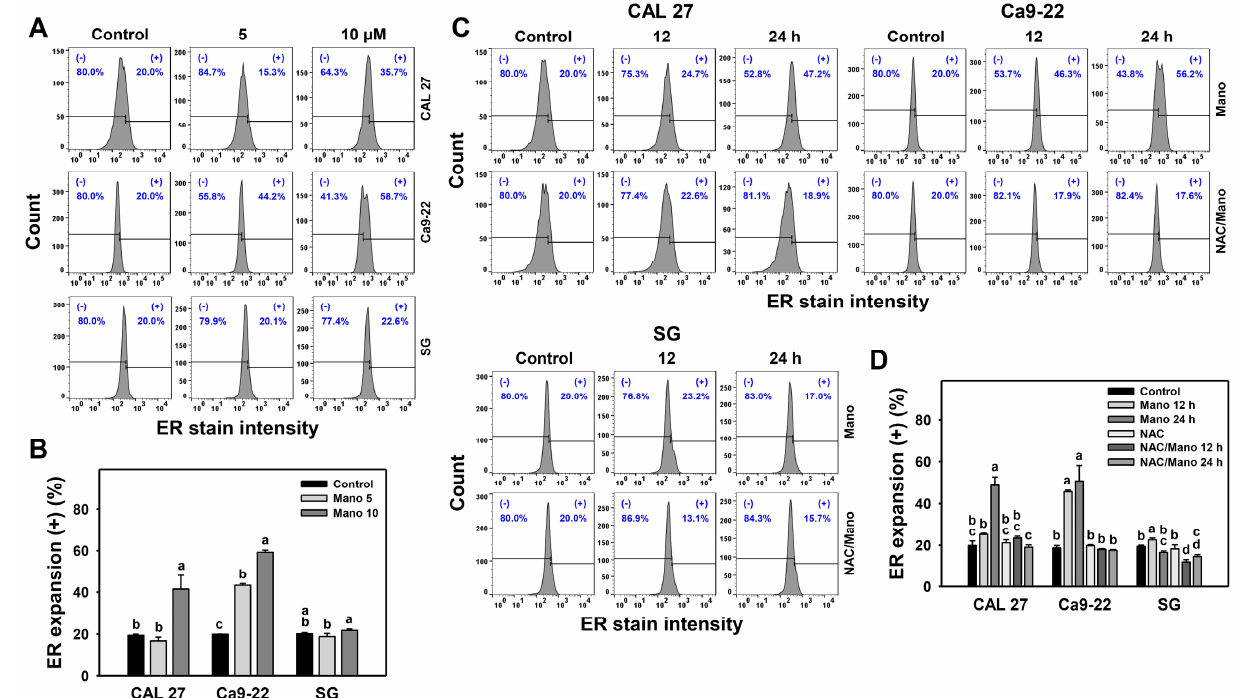
Figure 1. Manoalide causes ER expansion of oral cancer cells. ( A , B ) ER expansion analyses. Oral cancer (CAL 27 and Ca9-22) and normal oral (SG) cells received control, 5, and 10 µ M manoalide treatments for 24 h. (+) was marked for ER expansion (+) (%). ( C , D ) NAC effects on time course changes of manoalide-induced ER expansion. Following NAC (10 mM for 1 h), cells received manoalide treatment (control and 10 µ M) for 12 and 24 h, i.e., NAC/Mano. Data, means ± SDs ( n = 3). Multiple comparisons were analyzed for the same cell lines. Treatments marked with different notes indicate a significant difference ( p < 0.05 to 0.0001).